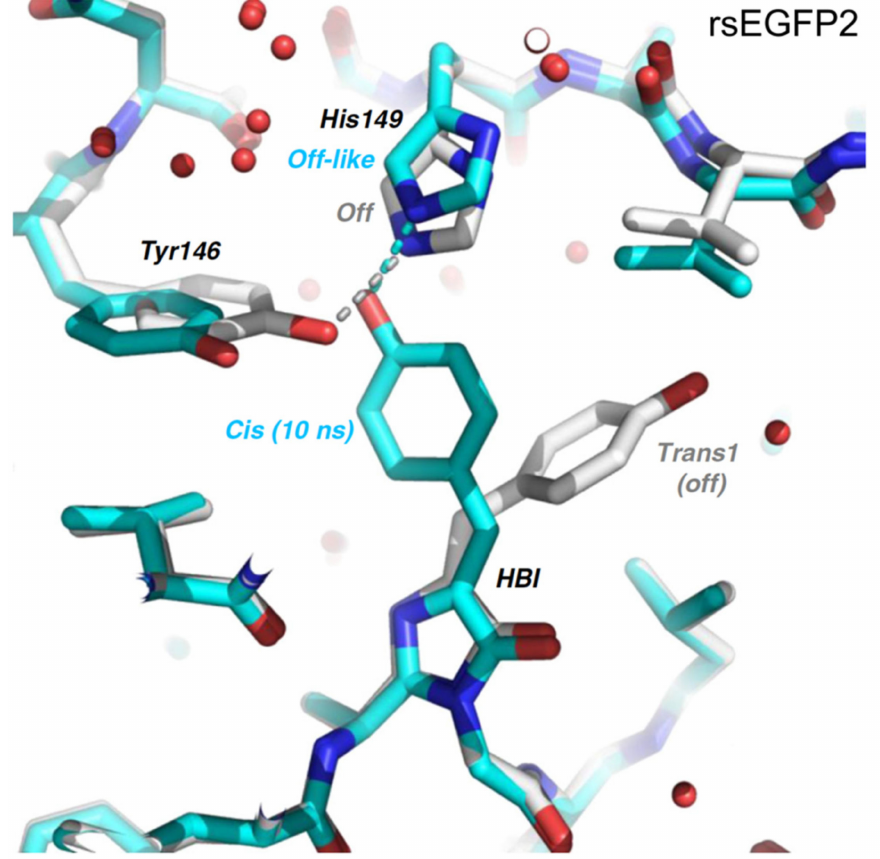
Figure 7. The 10 ns structure of rsEGFP2 during photoactivation. The cis -chromophore in the 10 ns intermediate (cyan; PDB ID: 6T3A) is overlaid with the trans -chromophore in the off state (gray, 65% occupancy major conformer), accompanied by a notable H-bonding partner change of His149 in off state (to Tyr146) versus 10 ns intermediate (to chromophore), denoted by the color-coded dashed lines. Reprinted with permission from Ref. [74]. Copyright 2020 The